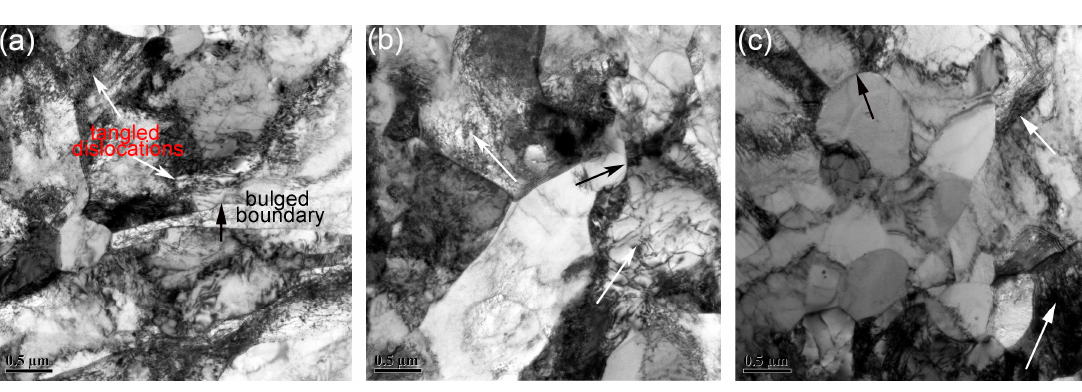
Figure 10. Substructures in the samples deformed with strain rate of 0.01 s − 1 at ( a ) 1050 ◦ C; ( b ) 1100 ◦ C; ( c ) 1150 ◦ C.